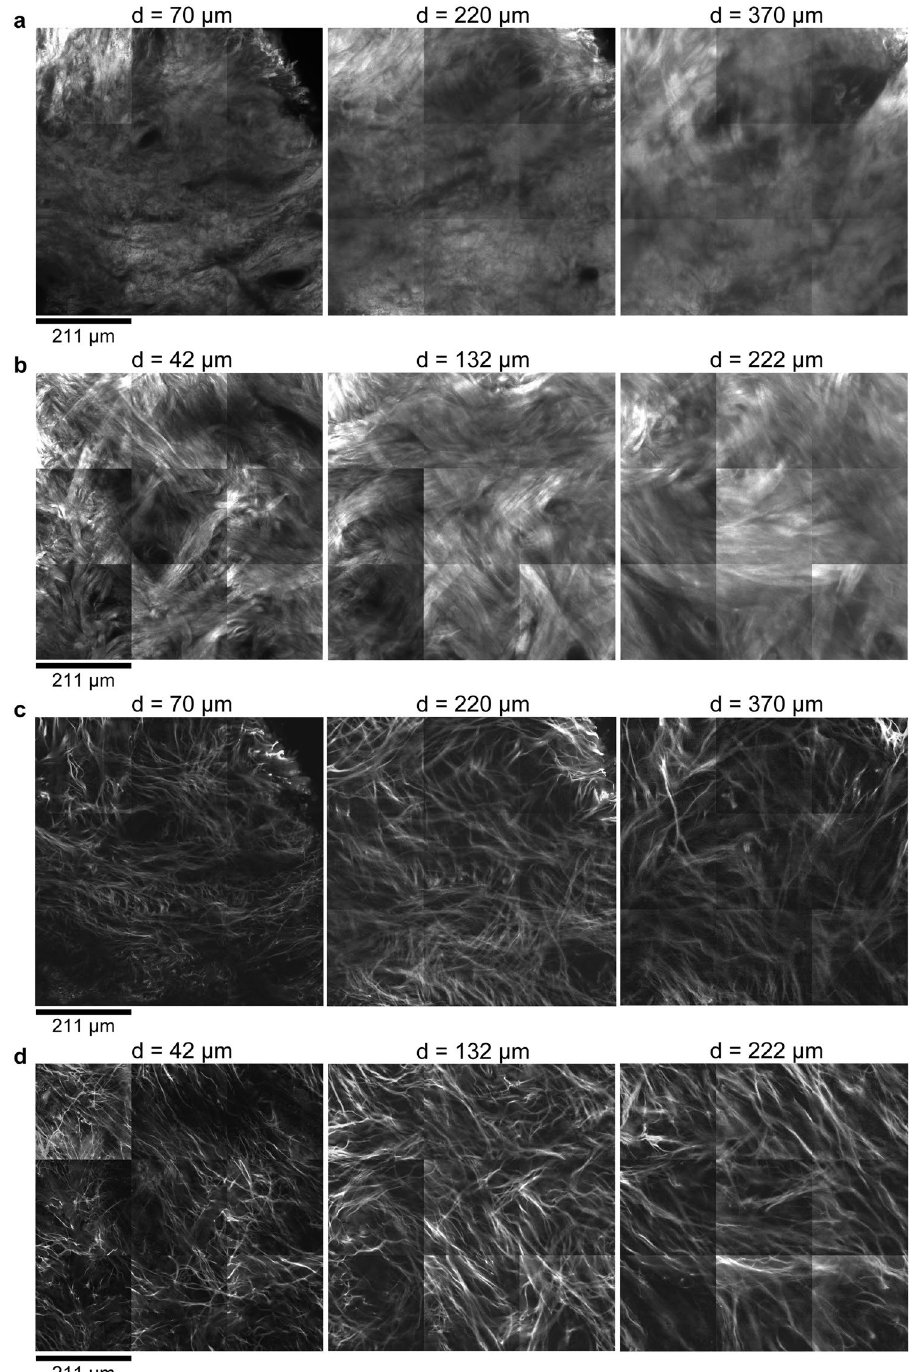
Figure 2. Impact of biaxial extension on the visibility of collagen architecture in the reticular dermis. Multiphoton microscopy images of the reticular dermis in unstretched ( a , c ) and biaxially extended ( b , d ) human skin samples. ( a , b ), Second harmonic generation (SHG) images. ( c , d ) Two-photon autofluorescence images. d indicates the distance from the papillary dermis–reticular dermis boundary. Since the skin was thinned 0.6-fold due to biaxial extension, the images in ( b , d ) are from 0.6 times the depth of the images in ( a , c ) for